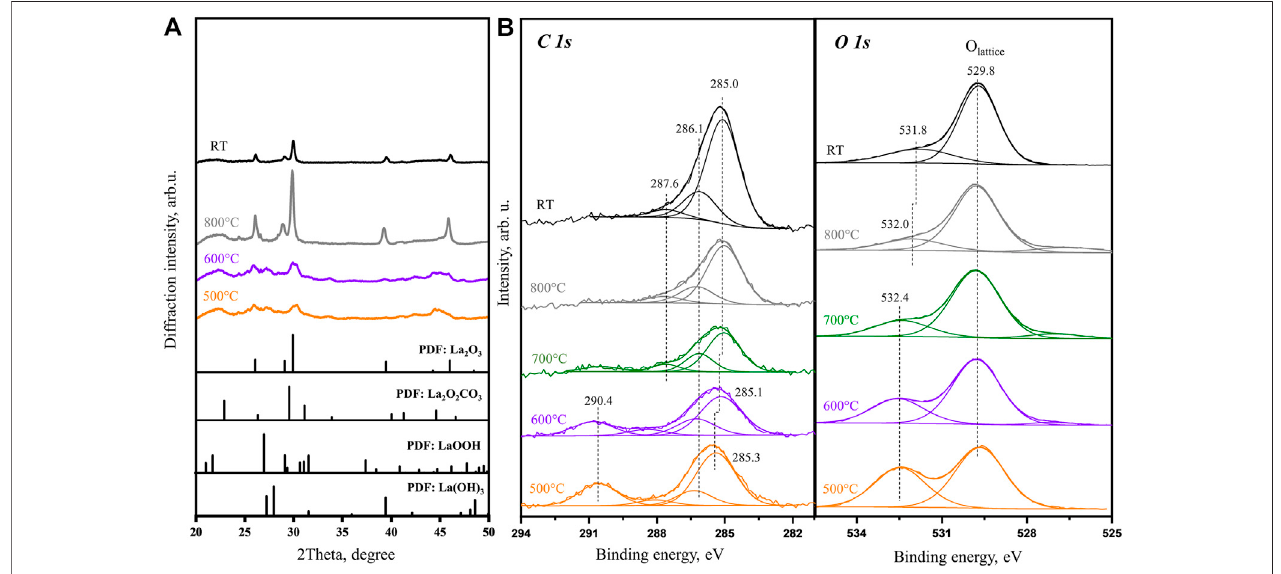
FIGURE 4 | (A) In situ XRD patterns obtained for La 2 O 3 sample at 500, 600, and 800 ° C with PDF database of references. spectra obtained at 500, 600, 700, and 800 ° C and after subsequent cooling to room temperature.